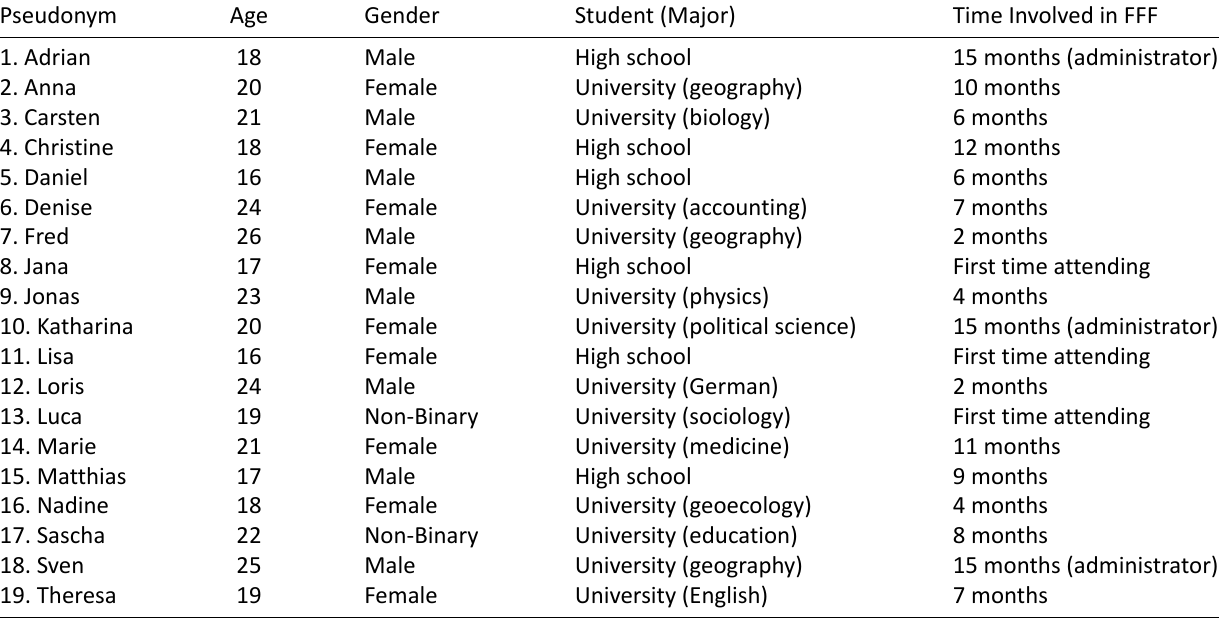
Table 1. Overview of study